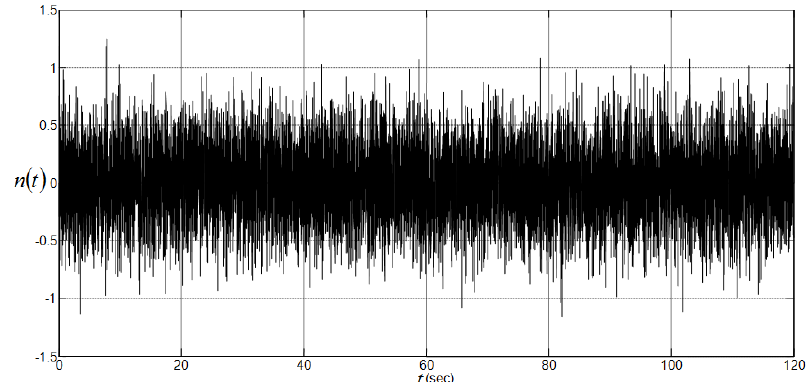
Figure 14. Input disturbance signal. Table 6. Performance in a noisy situation for 20 s ≤ t ≤ 120 s.